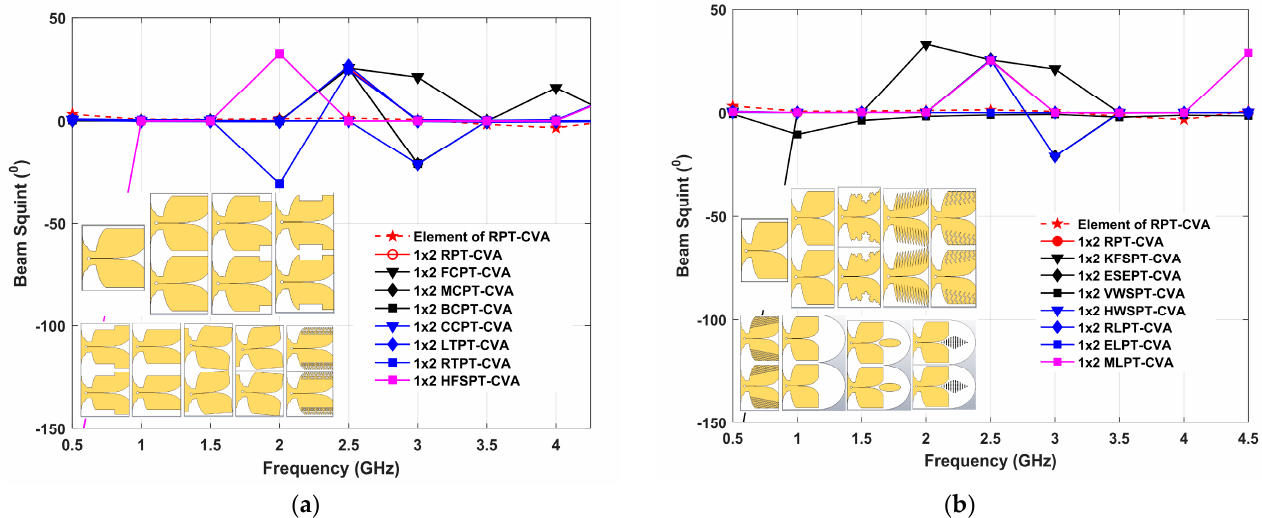
Figure 9. Beam Squint Performance of ( a ) Element and 1 × 2 Regular Palm Tree (RPT-CVA), 1 × 2 Front Cut Palm Tree (FCPT-CVA), 1 × 2 Middle Cut Palm Tree (MCPT-CVA), 1 × 2 Back Cut Palm Tree (BCPT-CVA), 1 × 2 Complete Cut Palm Tree (CCPT-CVA), 1 × 2 Left Tilt Palm Tree (LTPT-CVA), Right Tilt Palm Tree (RTPT-CVA), 1 × 2 Hilbert Fractal Structure Palm Tree (HFSPT-CVA), and ( b ). Element and 1 × 2 Regular Palm Tree (RPT-CVA), 1 × 2 Koch Fractal Structure Palm Tree (KFSPT-CVA), 1 × 2 Exponential Slot Edge Palm Tree (ESEPT-CVA), 1 × 2 Vertical Wave Structure Palm Tree (VWSPT-CVA), 1 × 2 Horizontale Wave Structure Palm Tree (HWSPT-CVA), 1 × 2 Regular Lens Palm Tree (RLPT-CVA), 1 × 2 Elips Lens Palm Tree (ELPT-CVA), and 1 × 2 Metamaterial Lens Palm Tree